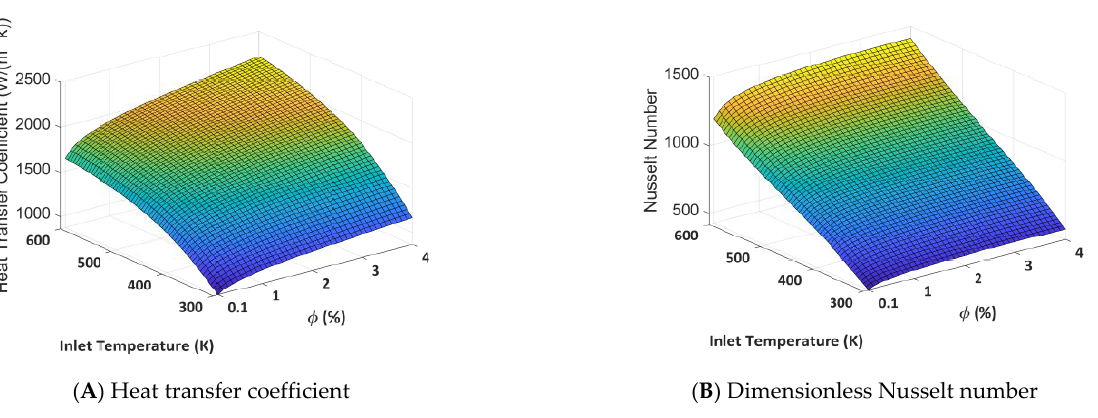
Figure 7. The 3D representation for the ( A ) heat transfer coefficient and ( B ) Nusselt number versus concentrations and